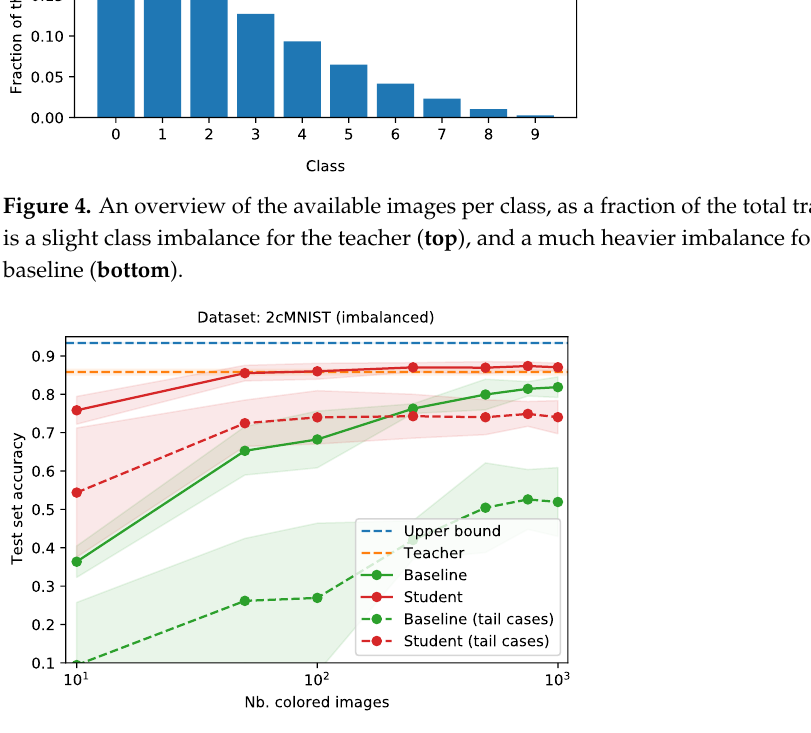
Figure 5. Comparison of the test set accuracy when training a neural network, with and without knowledge distillation, as a function of the train set size, for a heavily imbalanced train set. The dotted lines represent test set accuracy for the tail cases only, i.e., the digits “7”, “8” and “9”. Averages over three runs. Shaded areas indicate the standard